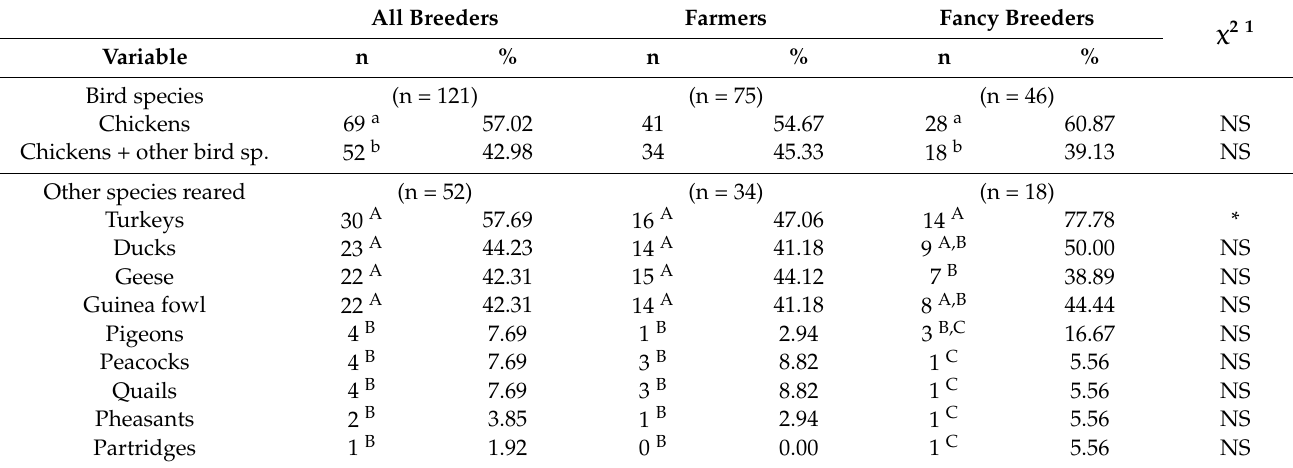
Table 2. Number of farms rearing chickens only or chickens plus other bird species: summary data for all breeders surveyed and divided according to breeder